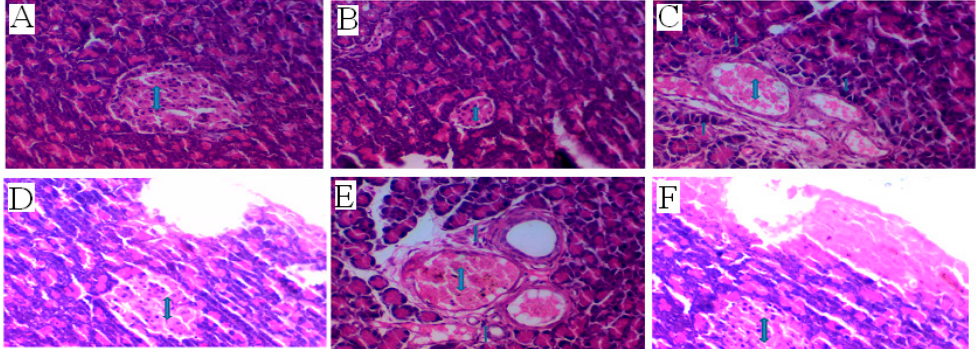
Figure 7. Histology of the pancreas. Pancreatic tissue was collected from each animal after 30 days of treatment. The tissue was sectioned, stained using H & E, and imaged using standard light microscopy at 400× magnification. Double-sided arrows ( ↕ ) denote islets of Langerhans. ( A ) Pancreas from healthy control animal (Group I); ( B ) Pancreas from STZ-treated diabetic animal (Group II); ( C ) Pancreas from STZ-treated diabetic animal (Group II); ( D ) Pancreas from animal treated with oxidovanadium(IV) sulfate alone (Group III); ( E ) Pancreas from animal treated with oxidovanadium(IV) sulfate alone (Group III); ( F ) Pancreas from animal treated with oxidovanadium(IV)–AMP complex (Group III).